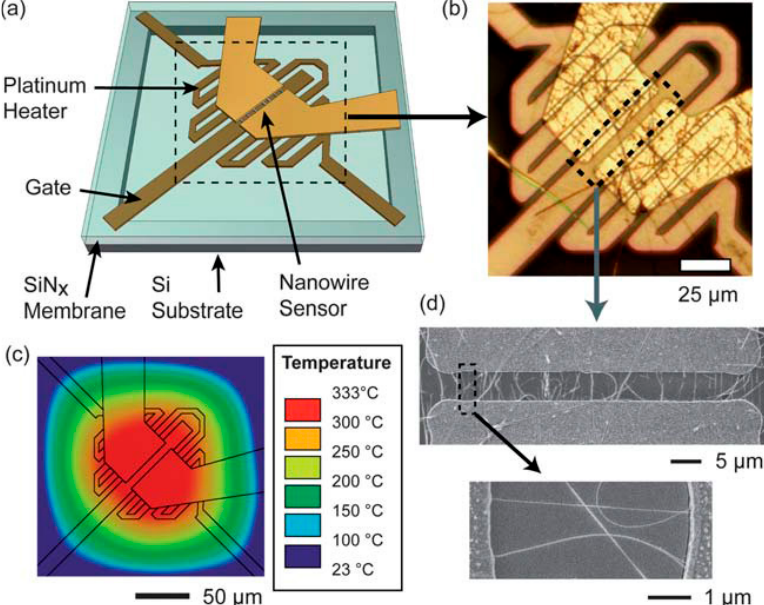
Figure 5. ( a ) The schematic view of the sensor fabricated on a silicon nitride membrane-based micro-hotplate platform. Different components, including Pt heater, gate and nanowire sensor etc. , are marked by the arrows. ( b ) An optical image of the device. ( c ) Simulating results at a typical working condition. ( d ) SEM images of the device. Reprinted from reference [72] with permission from the Royal Society of